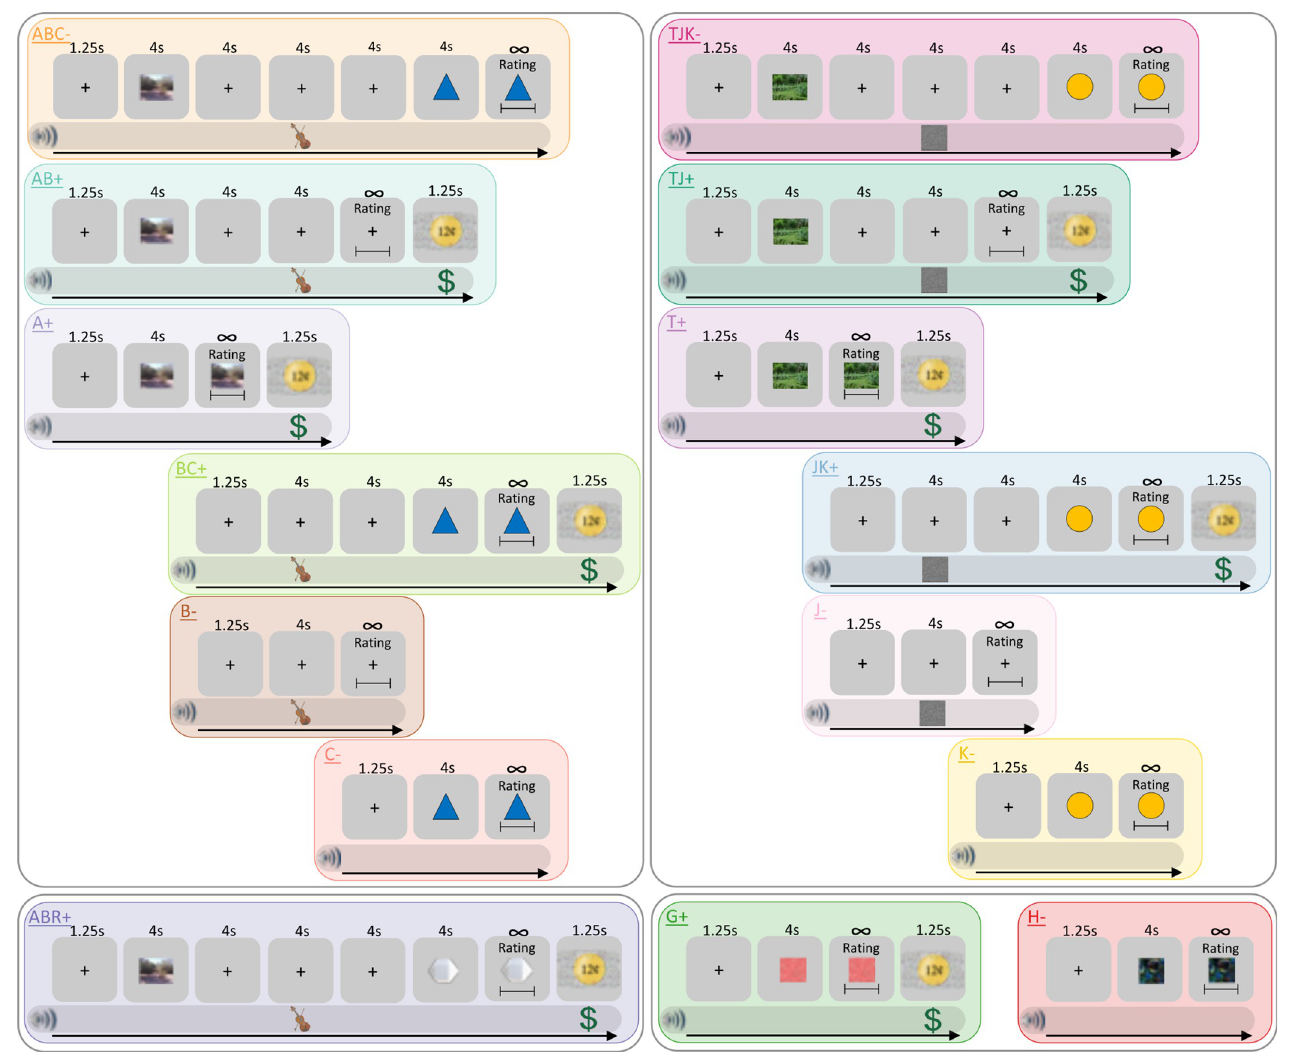
Fig 2. Experiment 1 (2 nd -Order Negative Occasion Setting) Trial Design. Each colored box represents a trial type. Gray boxes represent what was shown visually on screen. Inter-trial intervals (ITIs) and inter-stimulus intervals (ISIs) included a gray screen with a fixation cross (“+”). Duration of each trial component is shown at top of each trial type. Rating slide is shown in abbreviated form, and visual analog scale was used to rate US Expectancy. Images of nature scenes, shapes, and auditory stimuli indicate experimental stimuli (i.e., CSs, occasion setters). Auditory stimuli are indicated below slides in horizontal auditory band. Violin symbol indicates violin sound, static screen indicates white noise, and dollar sign indicates cash register sound. None of the auditory symbols were shown on screen during the experiment. Gold coin indicates monetary reward (US). Black arrow pointing to the right for each trial type indicates chronological component sequence during trials. All stimuli are counterbalanced across participants within stimulus category: G/H (Unambiguous CSs), C/K (Ambiguous CSs), B/J (1 st -order occasion setters), and A/T (2 nd -order occasion setters). All trial types for Experiment 1 are shown except TJR+, which is identical to ABR+, except T and J stimuli are substituted for A and B. Experiment 2 (2 nd -order POS) design is mirror image of Experiment 1 in which all trial types reinforced in Experiment 1 were not reinforced in Experiment 2, and all trial types not reinforced in Experiment 1 were reinforced in Experiment 2. The only exceptions are G+ and H-, which remained a CS+ and CS-, respectively, in each study. Images of violin, gold coin, confetti, fractals, and dollar sign were obtained from